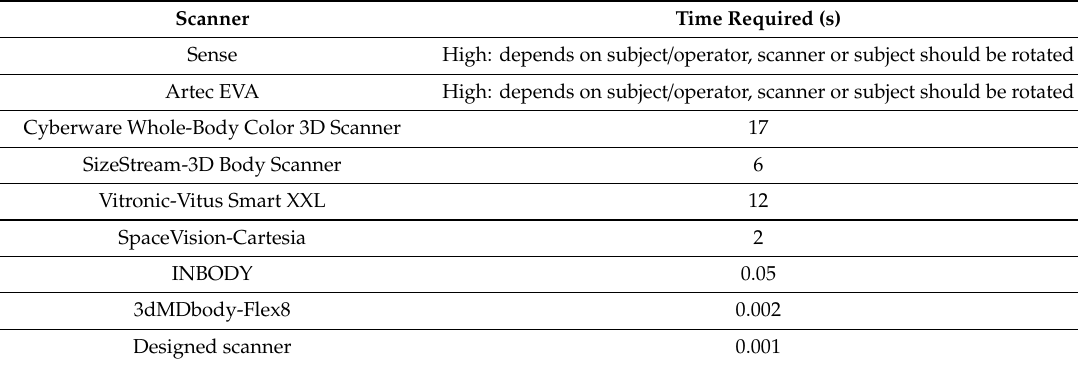
Figure 7. Sequence diagram of operation in the developed 3D scanner. Table 3. Time required for data acquisition by di ff erent human body 3D